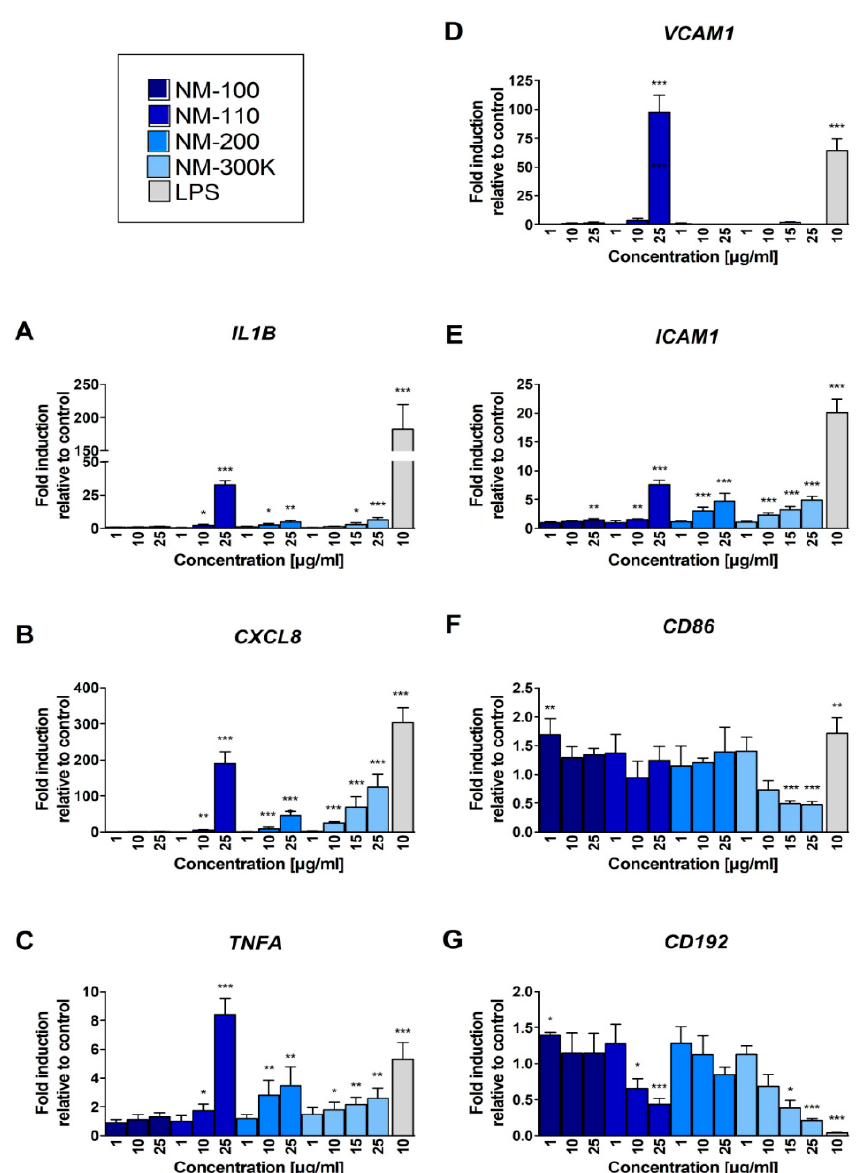
Figure 3. Real-time PCR quantification of fold changes in transcripts of selected immunologically relevant genes after 24-h exposure: IL1B ( A ), CXCL8 ( B ), TNFA ( C ), ICAM1 ( E ), VCAM1 ( D ), CD192 ( G ), and CD86 ( F ). The levels of mRNA were normalized to the untreated cells. Bars represent the mean of three replicates ± SD. Student’s t -test was used for statistical analysis of the results. * p < 0.05, ** p < 0.01, *** p < 0.001.